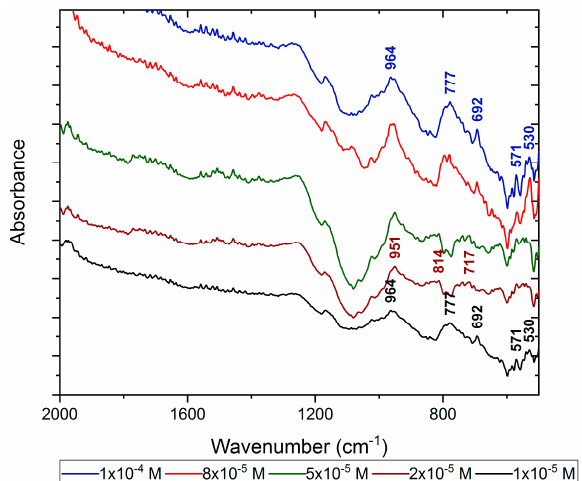
Figure 17. The DRIFT spectra of dithiophosphate adsorption on chalcopyrite with increasing collector concentration.